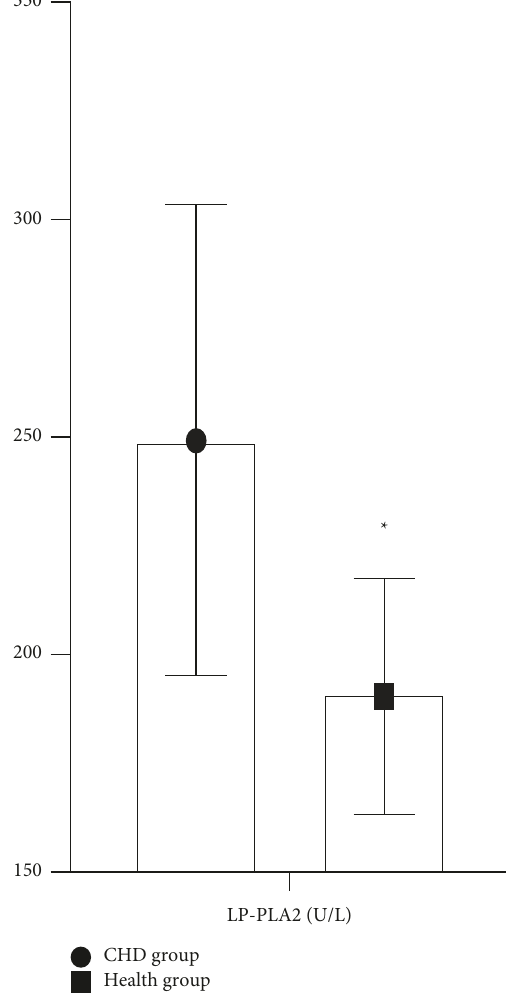
Figure 3: Serum IMA level (U/ml). Note: ∗ is P < 0 . 05 compared with the CHD group.